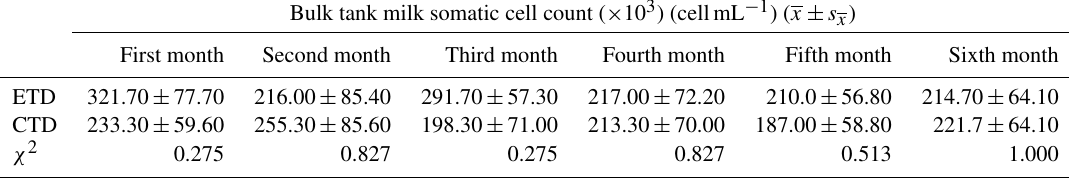
Table 2. Evaluation of bulk tank milk somatic cell counts on farms according to